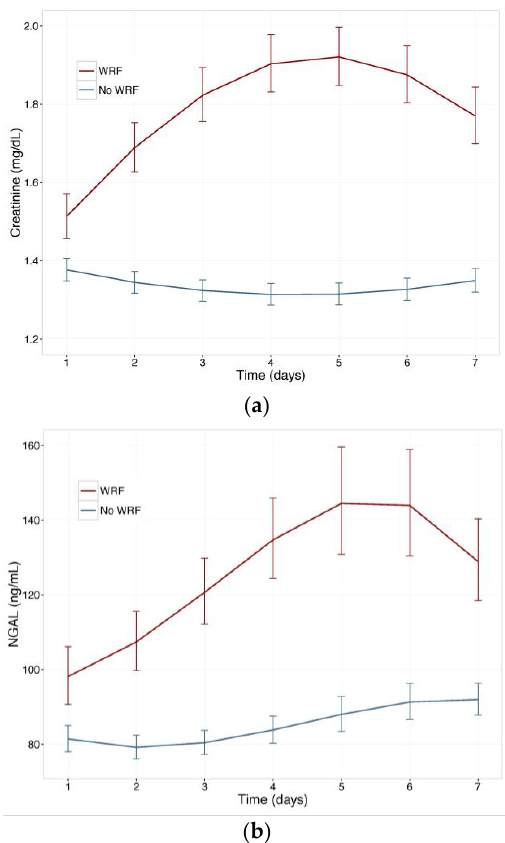
Figure 1. ( a ) Change in serum creatinine in patients with and without WRF; ( b ) Change in plasma Neutrophil Gelatinase-Associated Lipocalin (NGAL) in patients with and without WRF. Least square means, with 95% confidence intervals, WRF: worsening renal function, defined as a creatinine increase of ≥0.3 mg/dL by day 4.